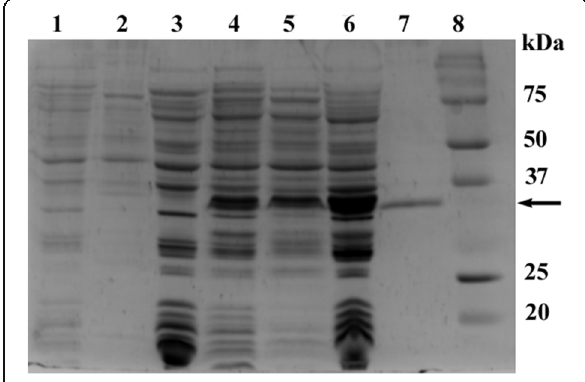
Fig. 9 Expression and purification analysis of recombinant Apc11. Lane 1, uninduced 1 ml crude; lane 2, uninduced supernatant; lane 3, uninduced pellet; lane 4, induced 1 ml crude; lane 5, induced supernatant; lane 6, induced pellet; lane 7, purified protein; lane 8, molecular weight marker. A specific band around ~ 36 kDa indicates induced EhApc11 fusion